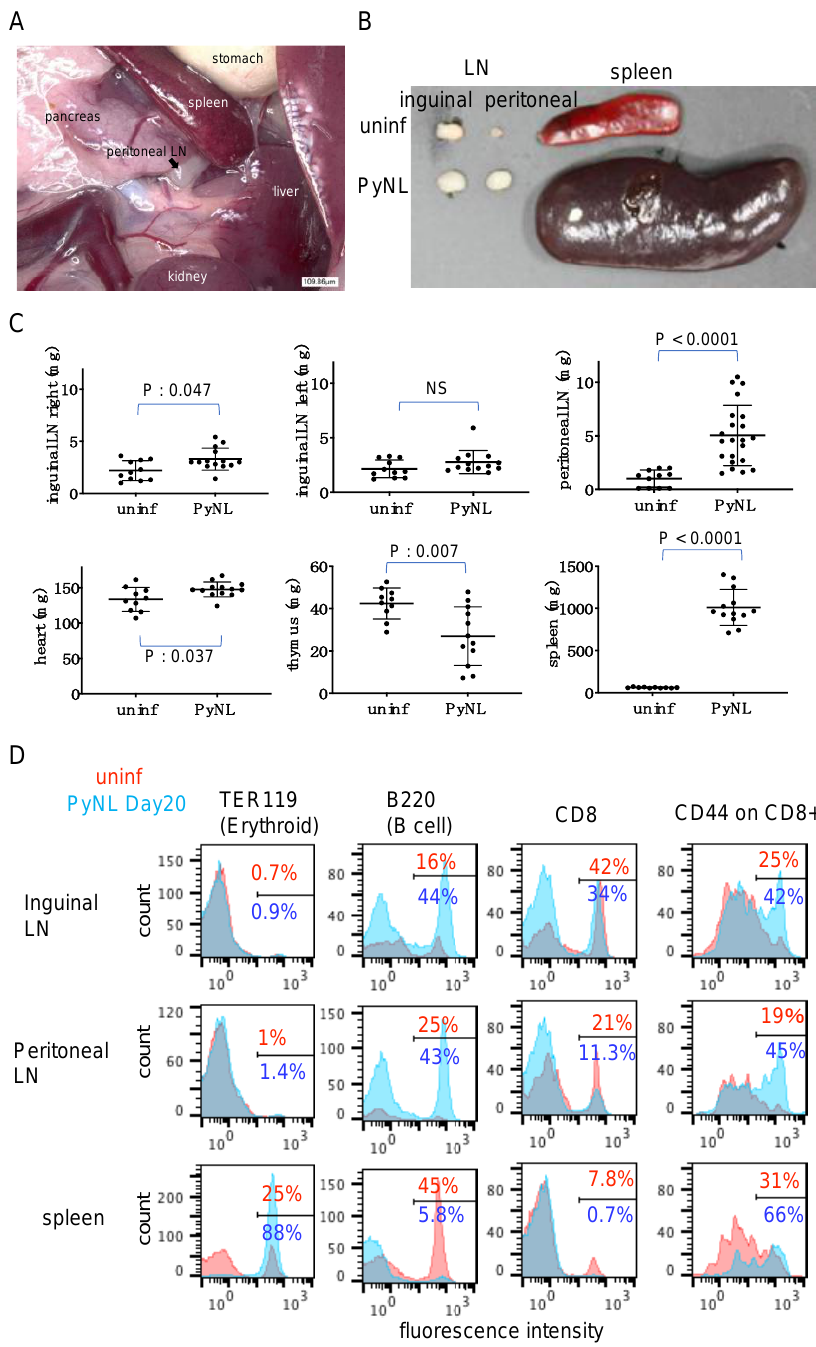
Figure 2. Changes in organ weight and cell proportion following vaccination with blood-stage PyNL. ( A ) Dissected mouse abdomen after PyNL infection. ( B ) Comparison of size and color of spleen and lymph node (LN) between the uninfected mouse (uninf) and PyNL-infected mouse at day 20 post-infection. ( C ) Changes in organ weight; inguinal LN (left and right), peritoneal LN, heart, thymus and spleen were assessed (week 3 – 4 after infection). Each symbol represents one mouse (N = 11 – 22). Bars indicate mean ± SD. NS: not significant. ( D ) Flow cytometry analysis of LN and spleen (RBC were not lysed). Overlaid histogram shows uninfected animals (red) and PyNL-infected mice (blue) at day 20. Numbers indicate average (N = 3 mice) proportion of the positive population (erythroid, B, CD8, CD44 in CD8 + cells) within gated cells. Gating strategy is shown in Figure S2.